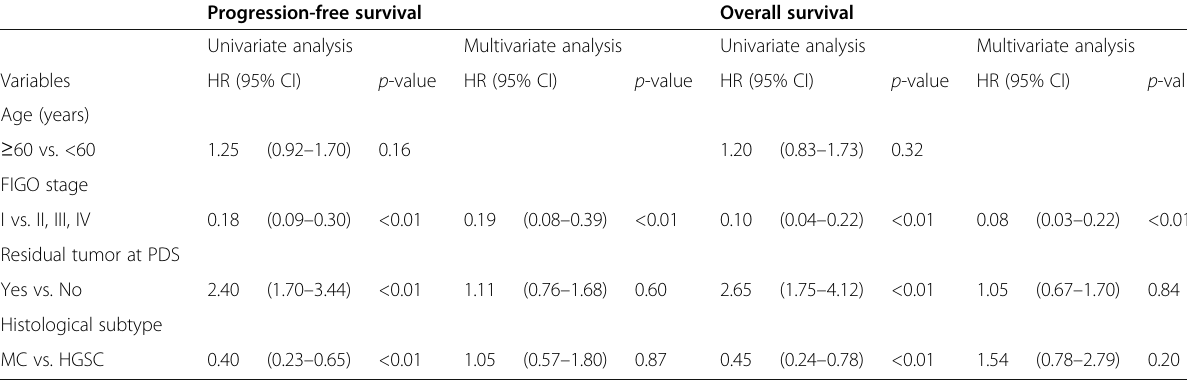
Table 2 Survival analysis for cases of mucinous carcinoma and high-grade serous